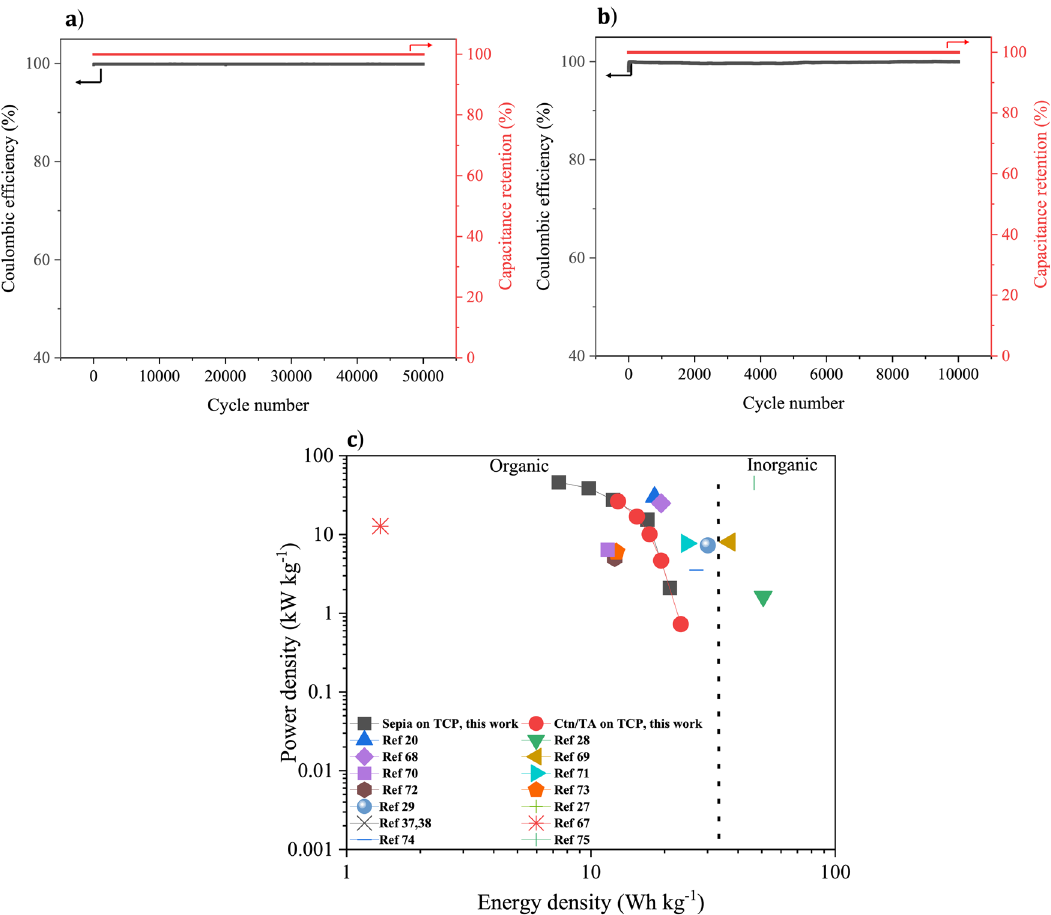
Fig. 6 Electrochemical characterization of sepia and Ctn/TA symmetric supercapacitors deposited on treated carbon in 0.5 M Na 2 SO 4 . Capacitance retention and coulombic ef fi ciency for 50 000 and 10 000 cycles of galvanostatic charge/discharge at 10 A g − 1 of ( a ) Sepia on TCP and ( b ) Ctn/TA on TCP. ( c ) is the Ragone plot extracted from galvanostatic charge/discharge cycles at different current densities: 0.5, 2, 4, 8, and 10 A g − 1 , compared with the state of the art in literature. See refs. 22,29 – 31,39,40,69,71 – 78 and table S1 for a more comprehensive study that includes a wider range of organic, inorganic, and hybrid